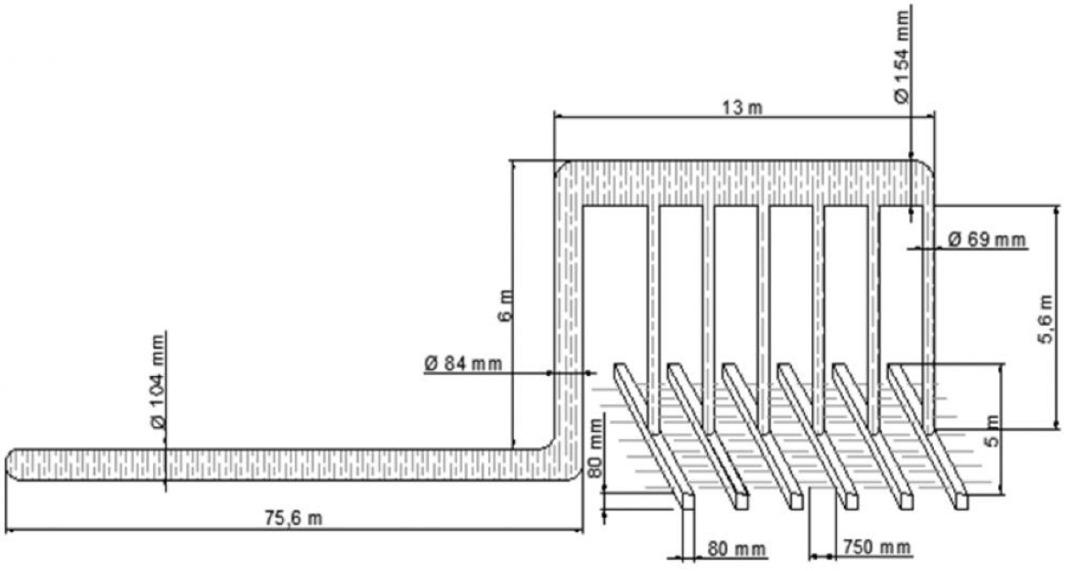
Figure 6. Schematic diagram of the pipeline.